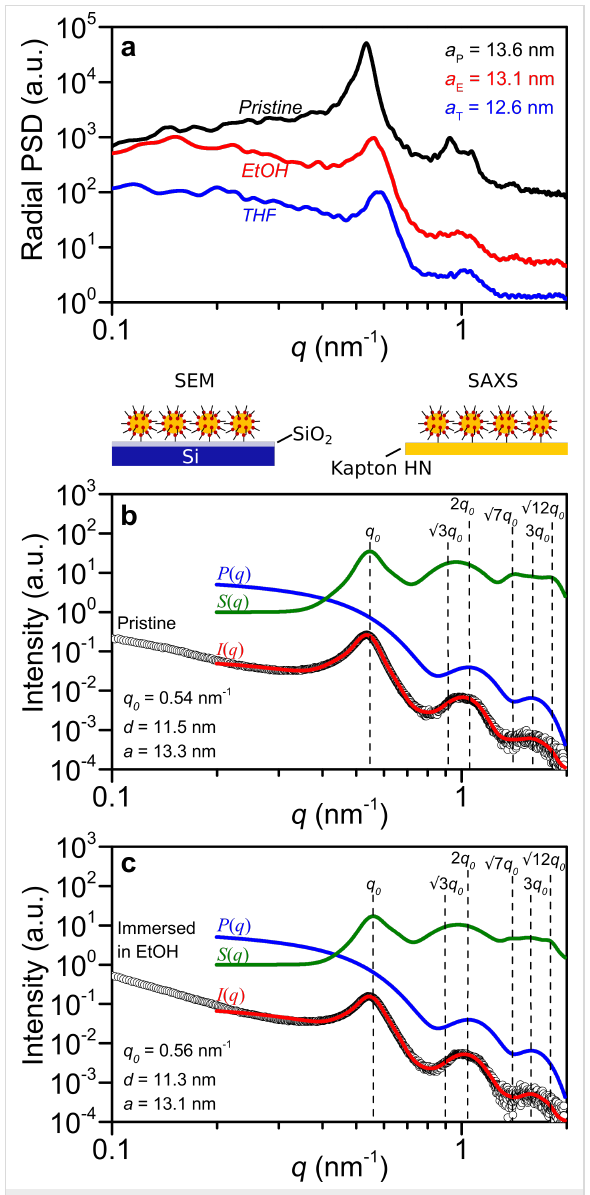
Figure 3: Evolution of gold nanoparticle monolayers upon solvent immersion measured by SEM and SAXS. (a) Radial power spectral density calculated from the respective SEM images in Figure 2 and the corresponding extracted lattice parameters. SAXS intensity profiles are shown for (b) a pristine nanoparticle monolayer and for (c) a nanoparti- cle monolayer immersed in EtOH. Fitting curve: I ( q ) = NP ( q ) S ( q ) + bkg. Form factor: P ( q ) = polydisperse spherical nanoparticle model. Struc- ture factor: S ( q ) = 2D hexagonal packing of spheres.